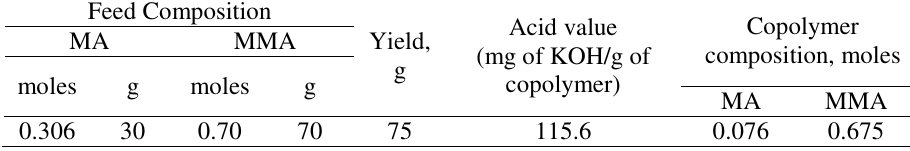
Table 2. Characteristics of AAR (MA-MMA